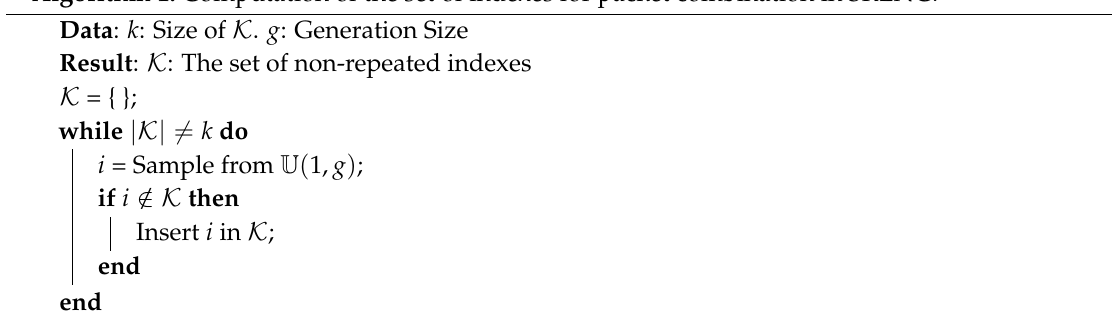
Algorithm 1: Computation of the set of indexes for packet combination in